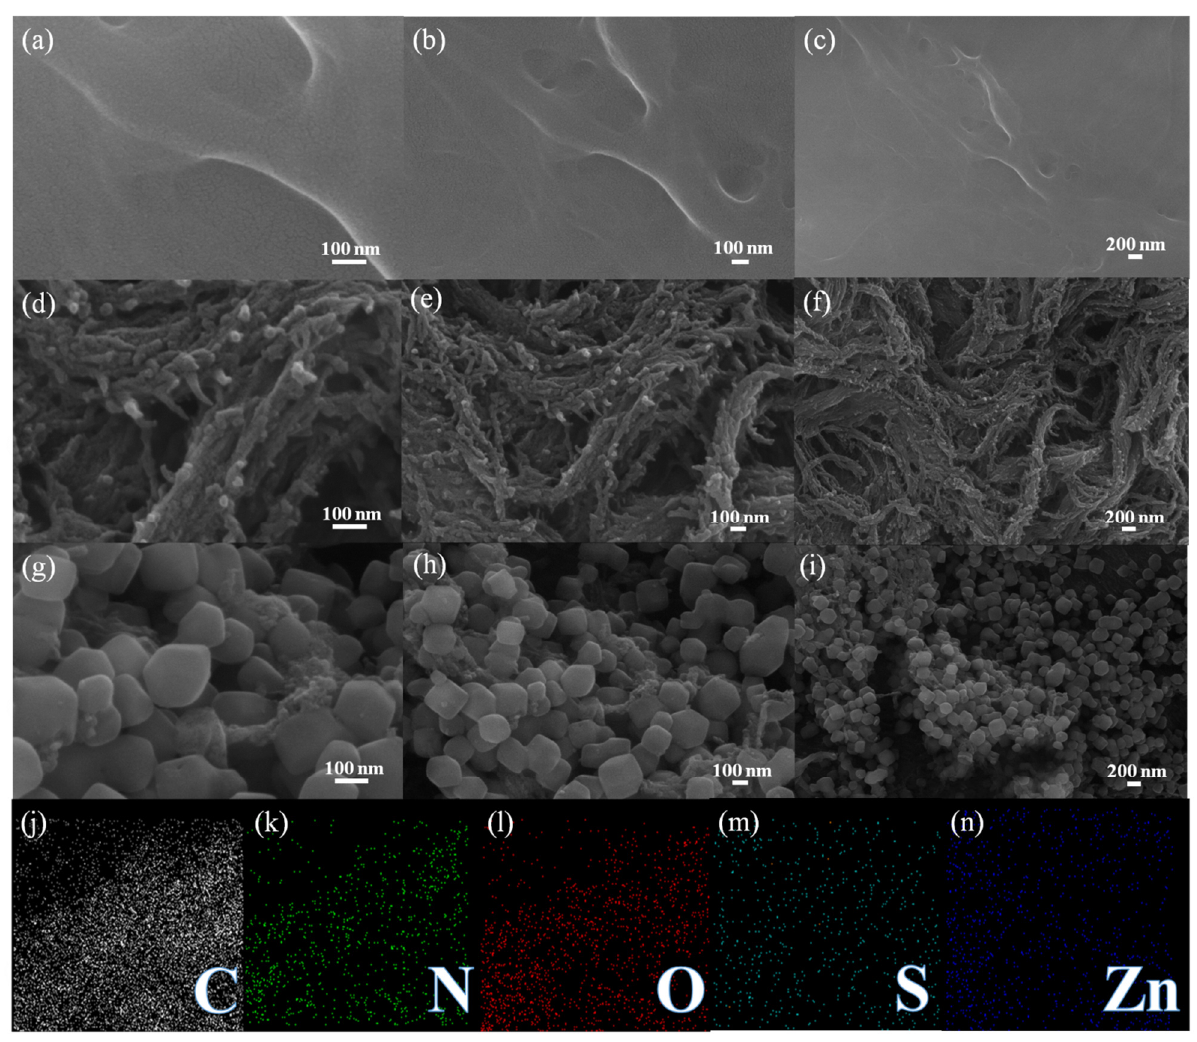
Figure 3. SEM images of CelF ( a – c ), MO-PPy@CelF ( d – f ), ZIF-8/MO-PPy@CelF ( g – i ); EDS images of ZIF-8/MO-PPy@CelF ( j – n ).